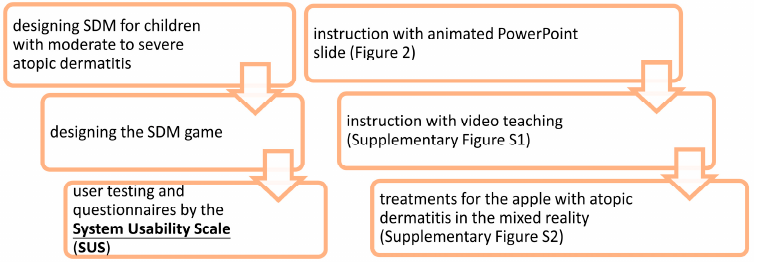
Figure 1. The structure of this prospective study and shared decision-making (SDM) game. Table 1. System usability scale of multimedia mixed reality interactive game of shared decision- making in participating children.